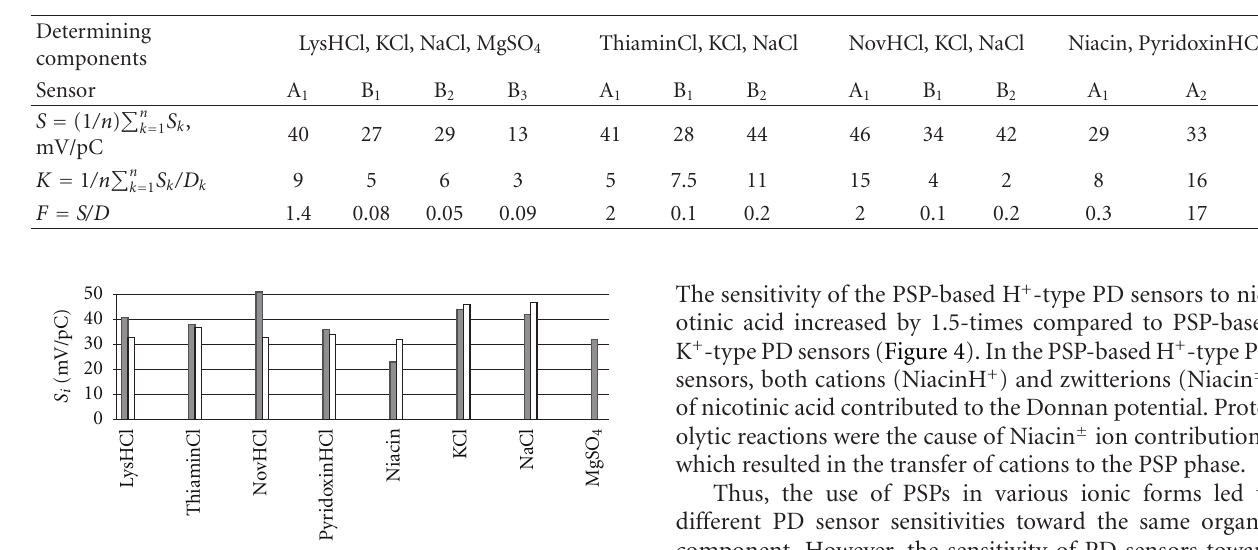
Table 1: The factors for the estimation of the cross-sensitivity of sensors A k , B k .